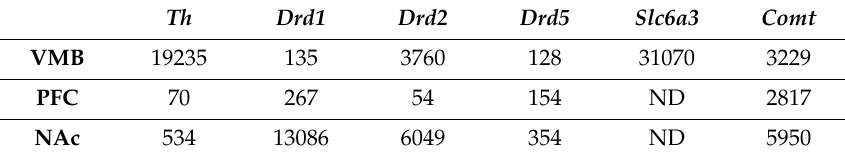
Table 1. Average reads for monoaminergic genes in specific brain